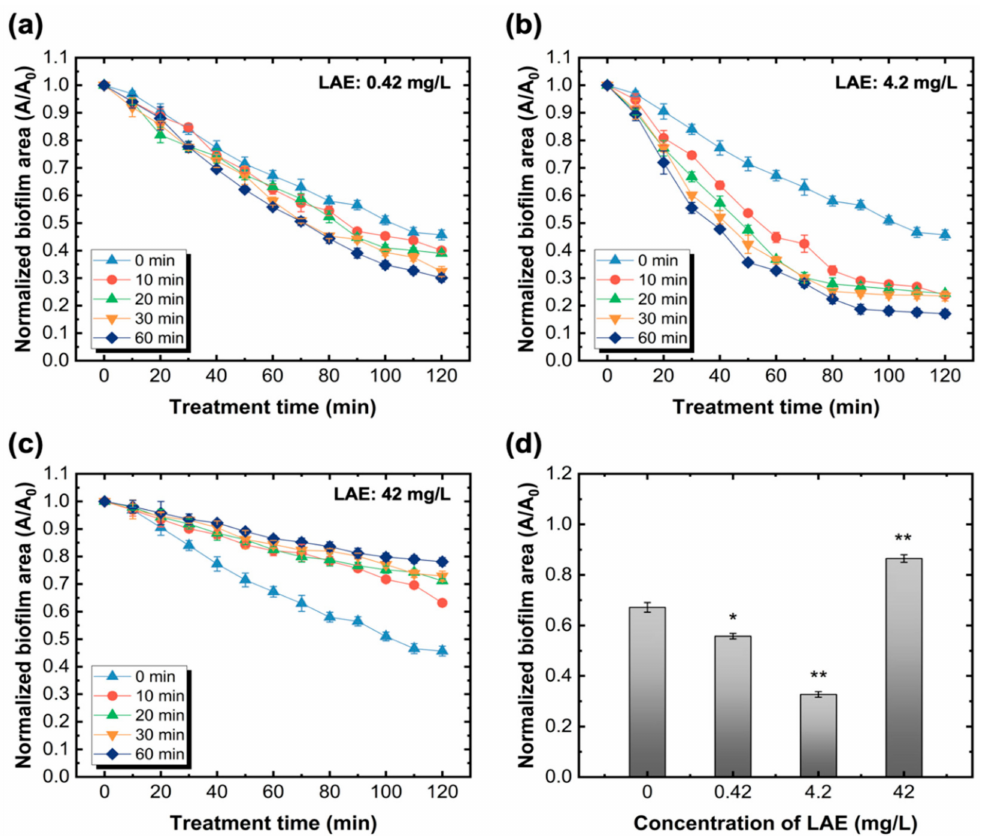
Figure 3. Detachment of biofilm formed on the glass slide surface under different LAE concentration and dosing time. ( a – c ) are the effects of LAE dosing time (0, 10, 20, 30, and 60 min) on the biofilm area reduction under different LAE concentrations of 0.42 mg/L, 4.2 mg/L, and 42 mg/L, respectively. ( d ) Changes of normalized biofilm area treated with different LAE concentrations for 60 min. Other experimental conditions: the biofilm was continuously flowed with PBS buffer after treating with LAE until the total treatment time reached 120 min. All shear rates were set to 3.42 s − 1 . Error bars indicate the standard deviations of three independent measurements. * p < 0.05 versus control, ** p < 0.005 versus